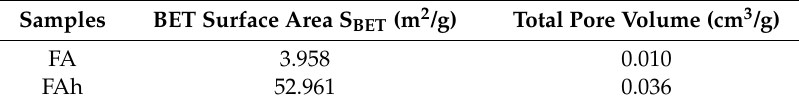
Table 2. Porous characteristics of FA and FAh.